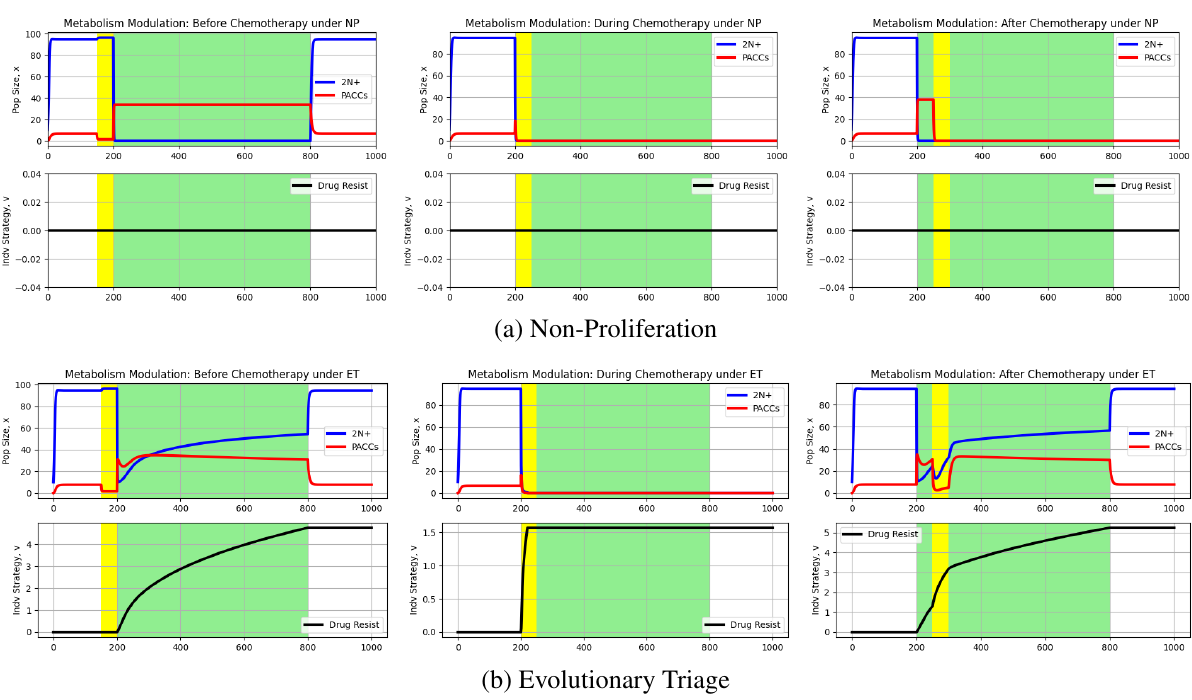
Figure 6. Effect of metabolism modulation on eco-evolutionary dynamics of cancer cell population. Blue and red curves depict 2N+ and PACC population dynamics, respectively, and the black curve captures the evolutionary dynamics of resistance. White and green backgrounds reflect periods without and periods with chemotherapy, respectively, and yellow backgrounds are periods with a metabolic drug. Under ET, the metabolic drug promoted extinction of the cancer cell population when administered at the same time as chemotherapy. Under NP, the metabolic drug was able to eradicate the cancer when administered at the same time as or 50 time steps after the start of